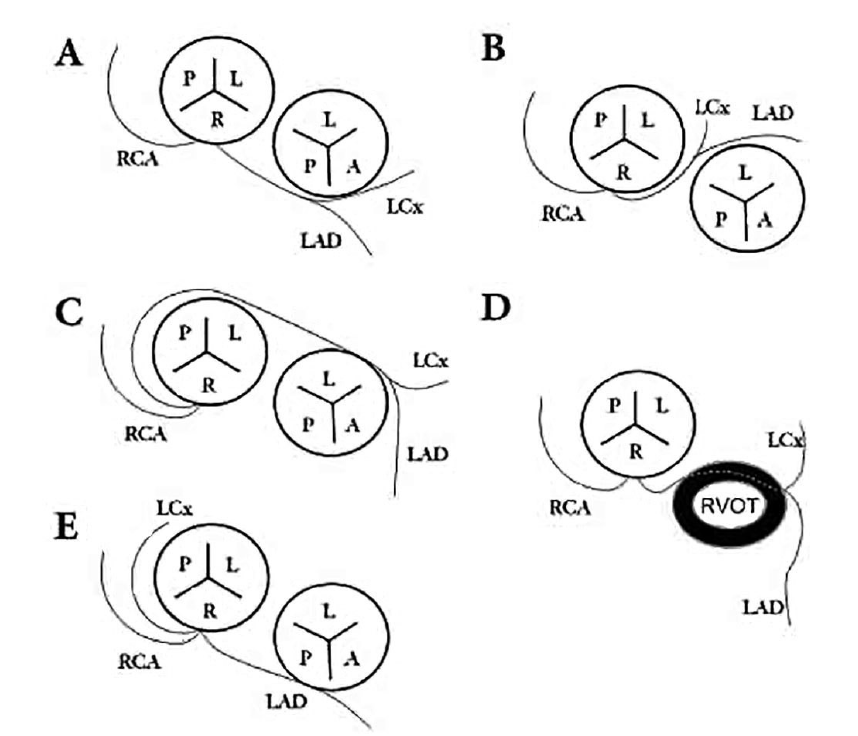
sinus.Fig. 2 - Left coronary artery arising from the right coronary sinus [12,13] : (A) from a separate ostia with the right coronary artery; (B) sharing a same ostia with the right coronary artery coursing between the aorta and pulmonary artery; (C) sharing a same ostia with the right coronary artery with a retroaortic course; (D) coursing via the right ventricular outflow tract; and (E) with an anterior course of the left anterior descending coronary artery and a retroaortic course of the left circumflex